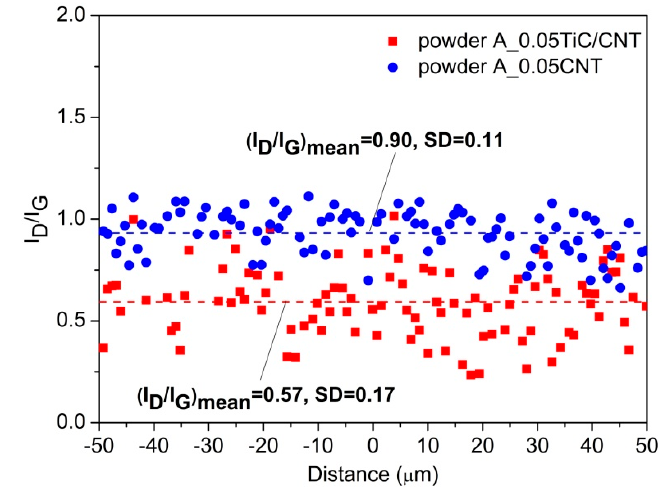
Figure 7. Typical I D /I G Raman intensity ratio measured over lines of longitudinal cross-sections: A_0.05CNT and A_0.05TiC/CNT composite powders.